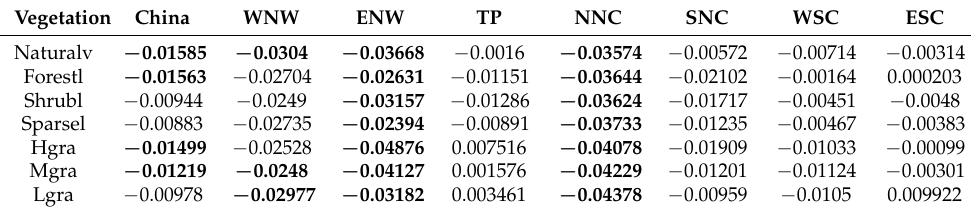
Figure 8. The changes to the Standardized Precipitation Evapotranspiration Index (SPEI) ( a ) and correlations between the SPEI and the Normalized Difference Vegetation Index (NDVI) in China ( b ): during the growing season (GS); ( c ): between the NDVI of the current GS and the SPEI of the previous non growing season (NGS). Table 4. Regional trends in the Standardized Precipitation Evapotranspiration Index (SPEI) during the growing season in China (significant trends at the 0.05 significant level are indicated in bold).